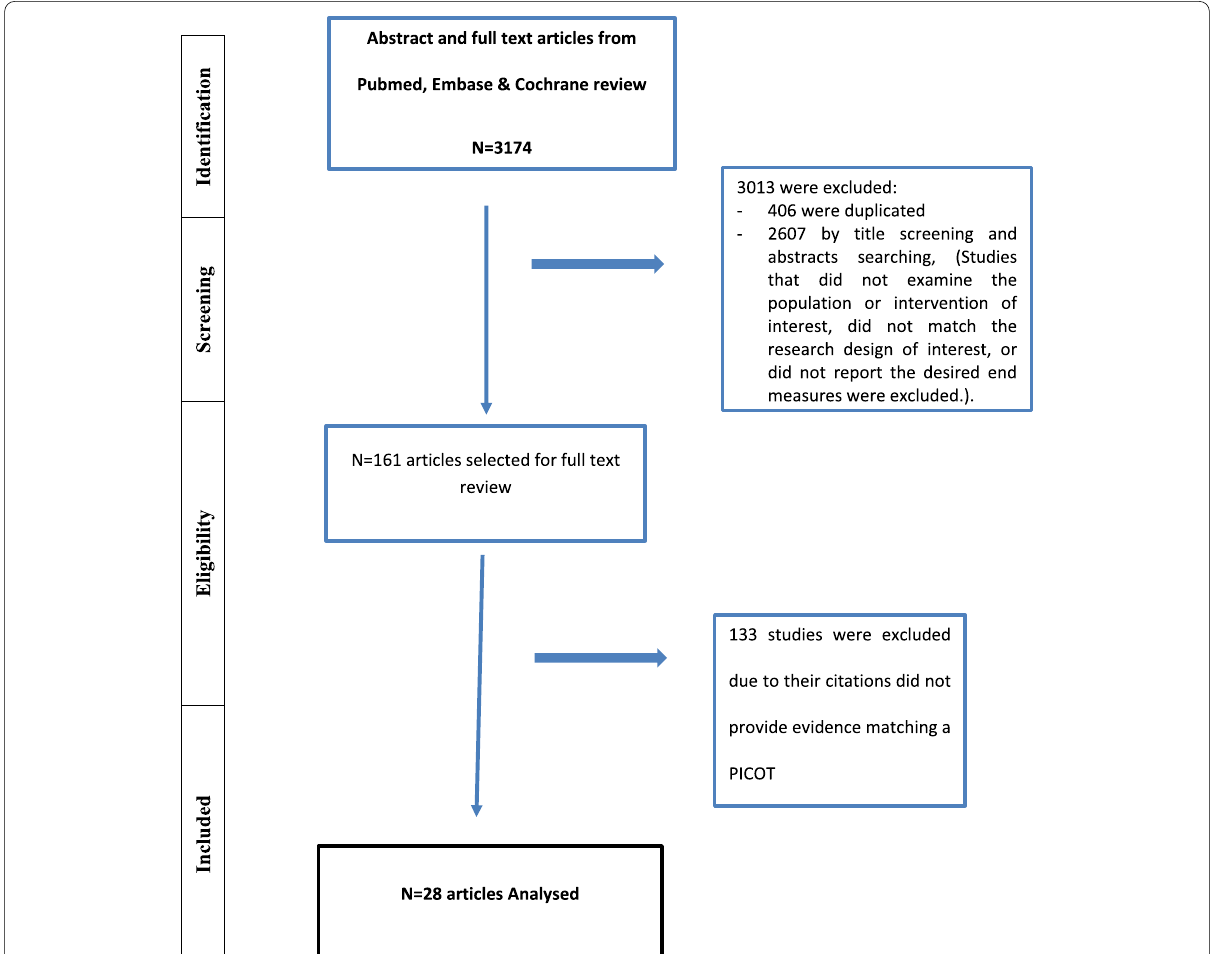
Fig. 1 Flow chart for the study selection